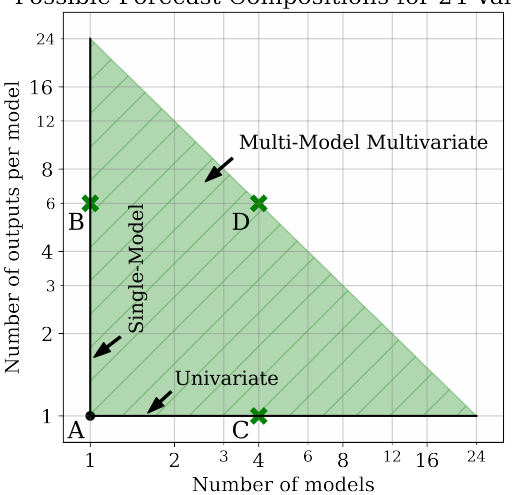
Figure 2. Possible forecast compositions in case of a 24-value-forecast are represented by the green triangle, edges included. Both the x- and y-axis are shown logarithmically with base two. Marked with A, B, C and D are four examples for the four different composition